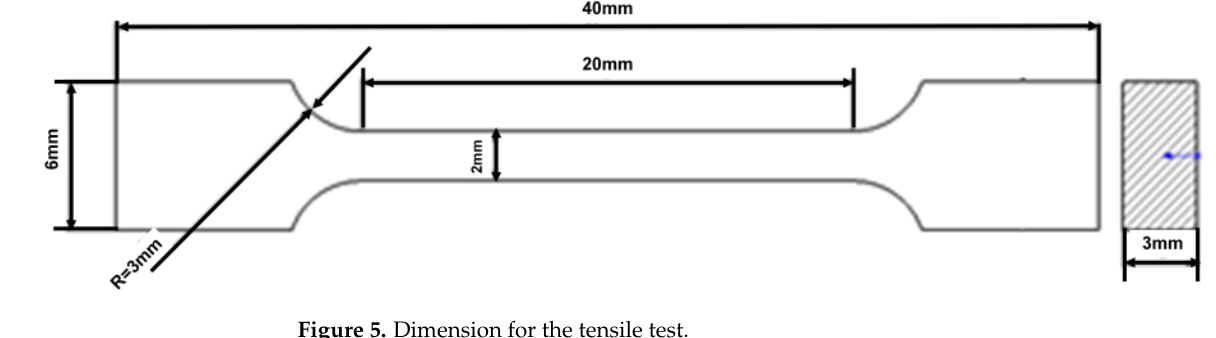
Figure 5. Dimension for the tensile